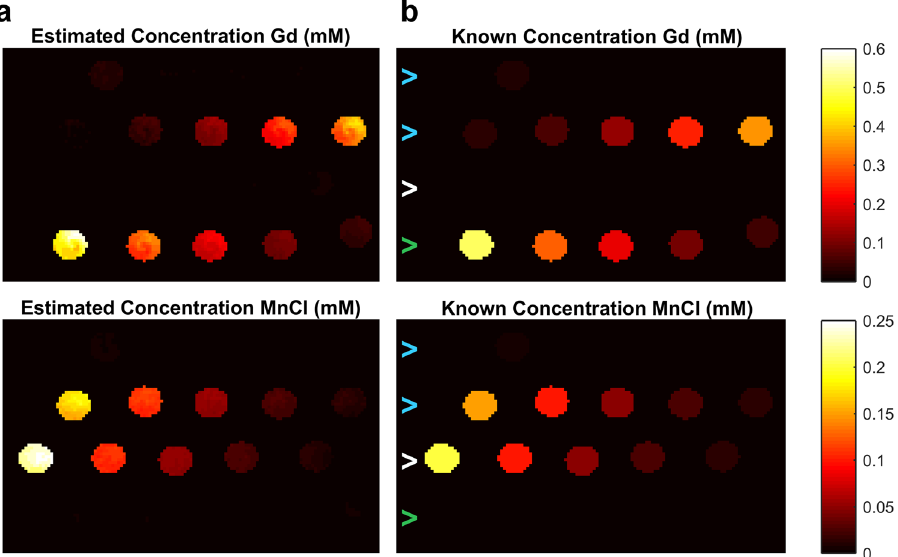
Figure 4. Maps of estimated gadolinium (Gd) and manganese (Mn) concentration from DC-MRF method ( a ). Simulated maps of known concentrations are shown for comparison ( b ). Note the general agreement between DC-MRF estimates and actual concentrations over a wide range of concentrations (n = 17). Note also the absence of signal from the vials containing only a single agent (bottom row of maps marked by green arrow contain only Gd, 3 rd row of maps marked by white arrow contain only Mn) indicating that the multiple contrast agent relaxation model and acquisition appears to be valid when the agents are used alone or in tandem (top two rows marked by blue arrows contain mixtures of both Gd and Mn contrast agents).